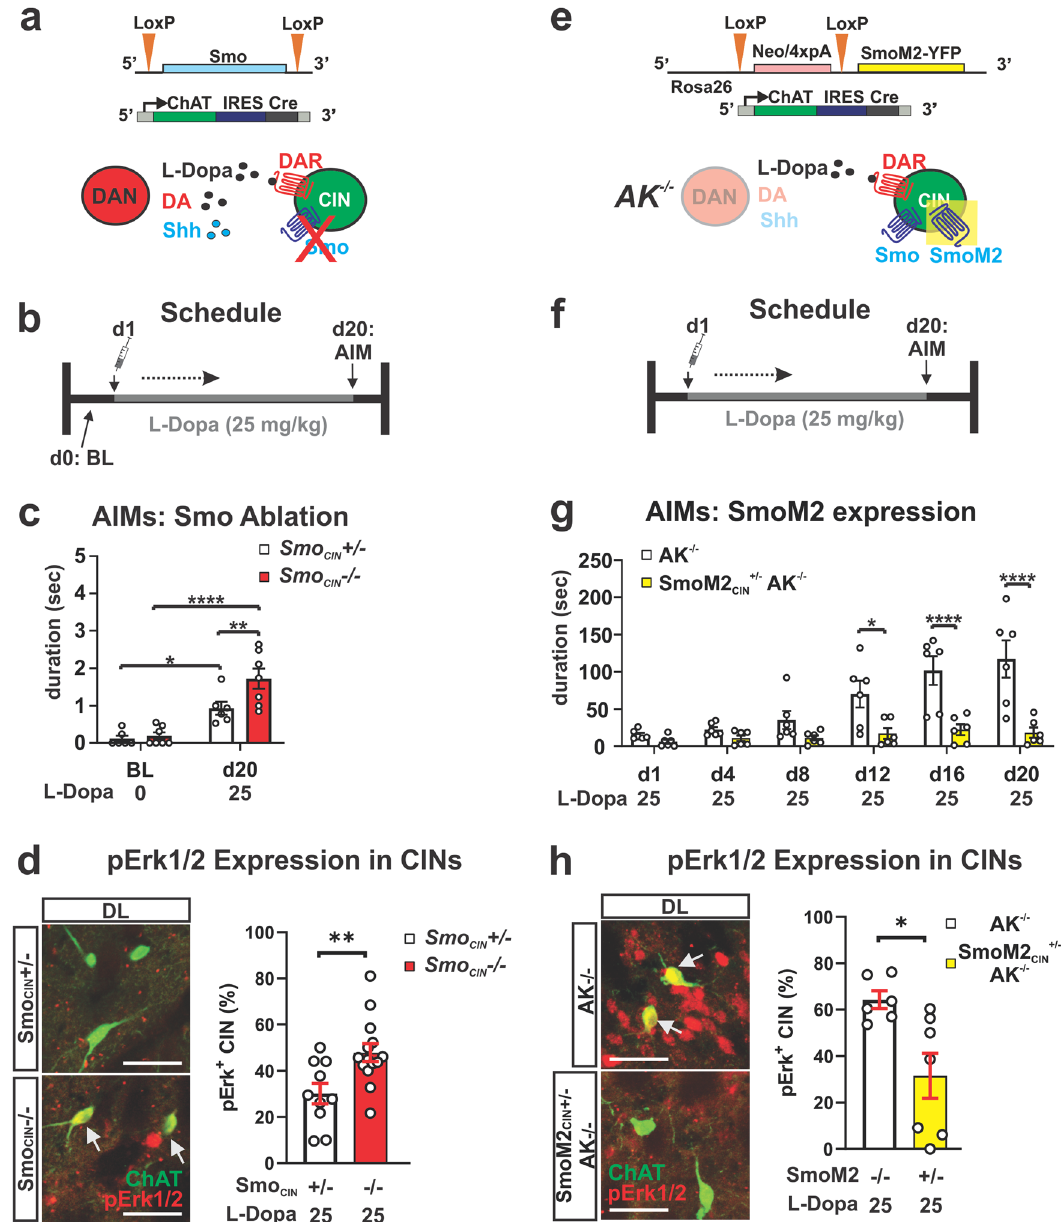
Fig. 4 Conditional genetic ablation of Smo from CIN facilitates LID while conditional expression of constitutively active SmoM2 in CIN inhibits LID. a Smo was selectively ablated from CIN by ChAT-IRESCre, which renders CIN insensitive to endogenous Shh signaling. b L-Dopa dosing schedule for the Smo loss-of-function study. c AIMs are increased in Smo CIN − / − mice compared to Smo CIN + / − heterozygous control littermates in response to daily injection of 25 mg/kg L-Dopa for 20 days ( n = 6 – 7 per genotype; RM two-way ANOVA day × genotype effect: F (1,11) 4.95, p = 0.048. Post hoc Bonferroni ’ s test: ** p < 0.01 control vs. mutant on day 20; day effect: F (1,11) = 52.61, p < 0.0001; * p < 0.05 control BL vs. day 20 and **** p < 0.0001 mutant BL vs. day 20). d Representative images of pErk 1/2 (red) co-localization (arrow) with CIN (ChAT, green). Quanti fi cation of pErk 1/2 prevalence in the posterior DLS of Smo CIN − / − and Smo CIN + / − heterozygous control littermates was performed following daily dosing with L-Dopa (25 mg/kg) for 20 days ( n = 10 – 14 per genotype; three sections each; 35 – 38 CIN per section). Unpaired two-tailed Student ’ s t test ** p < 0.01 control vs. mutant. n.s. indicates p > 0.05. Scale bar = 50 µ m . e Constitutively active SmoM2 was selectively expressed in CIN of AK − / − mice by ChAT-IRESCre, thus activating Smo signaling in CIN independent of endogenous Shh availibility. f L-Dopa dosing schedule for the SmoM2 gain-of-function study. g AIMs formation in response to daily injection of 25 mg/kg L-Dopa is suppressed in SmoM2 CIN + / − AK − / − mice compared to AK − / − ChAT-Cre + / − littermate controls ( n = 6 per genotype; RM two- way ANOVA time × genotype effect: F (5,50) = 8.16, p = <0.0001. Post hoc Bonferroni ’ s test: * p < 0.05, **** p < 0.0001 control vs. mutant). h Representative images of pErk 1/2 (red) co-localization (arrows) with CIN (ChAT, green). Quanti fi cation of pErk 1/2 prevalence in the posterior DLS and DMS of SmoM2 CIN + / − AK − / − and AK − / − ChAT-Cre + / − littermate controls was performed following daily dosing with L-Dopa (25 mg/kg) for 20 days ( n = 6 – 7 per genotype; three sections each; 35 – 38 CIN per section). Unpaired two-tailed Student ’ s t test * p < 0.05 control vs. mutant. n.s. indicates p > 0.05. All bar graphs are plotted as mean ± SEM. Scale bar = 50 µ